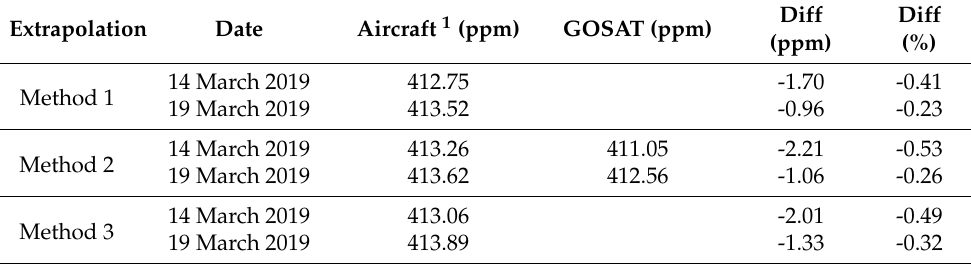
Figure 4. In situ CO 2 profiles measured by the UGGA and the column-averaged mole fraction CO 2 derived using various extrapolation methods: from satellite a priori profiles (Method 1), from GEOS-Chem CO 2 profiles (Method 2), and from the CarbonTracker CO 2 profiles (Method 3), along with GOSAT and OCO-2 XCO 2 measurements for 14, 16, and 19 March 2019. Table 3. The XCO 2 derived from the aircraft measurements using extrapolation Method 1 (satellite a priori concentrations), Method 2 (using GEOS-Chem profiles), and Method 3 (using CarbonTracker profiles), GOSAT XCO 2 values, the difference (GOSAT—Aircraft) in terms of ppm, relative difference (%).